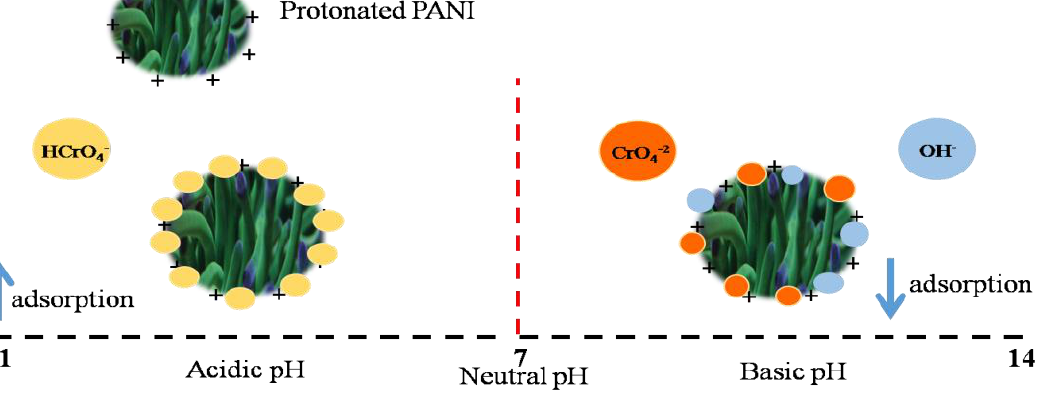
Figure 6. Schematic showing the mechanism of adsorption of chromium at acidic and basic pH ranges.